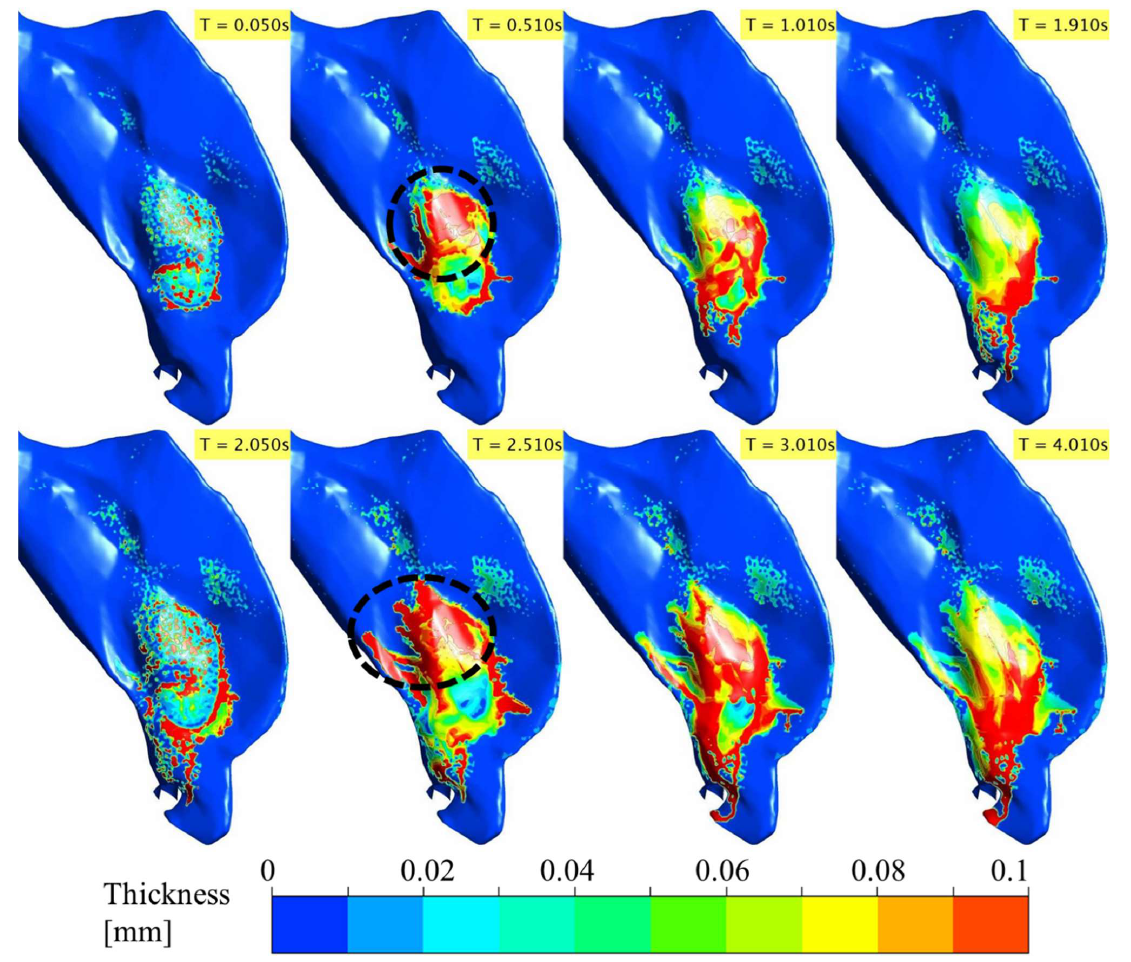
Figure 5. Evolution of the deposited Flonase Sensimist liquid on the nasal airway surface during the two spray actuation cycles at specific time points noted in the upper right corner of each sub-figure panel. (Dotted circle represents the high liquid mass concentration in the posterior region).